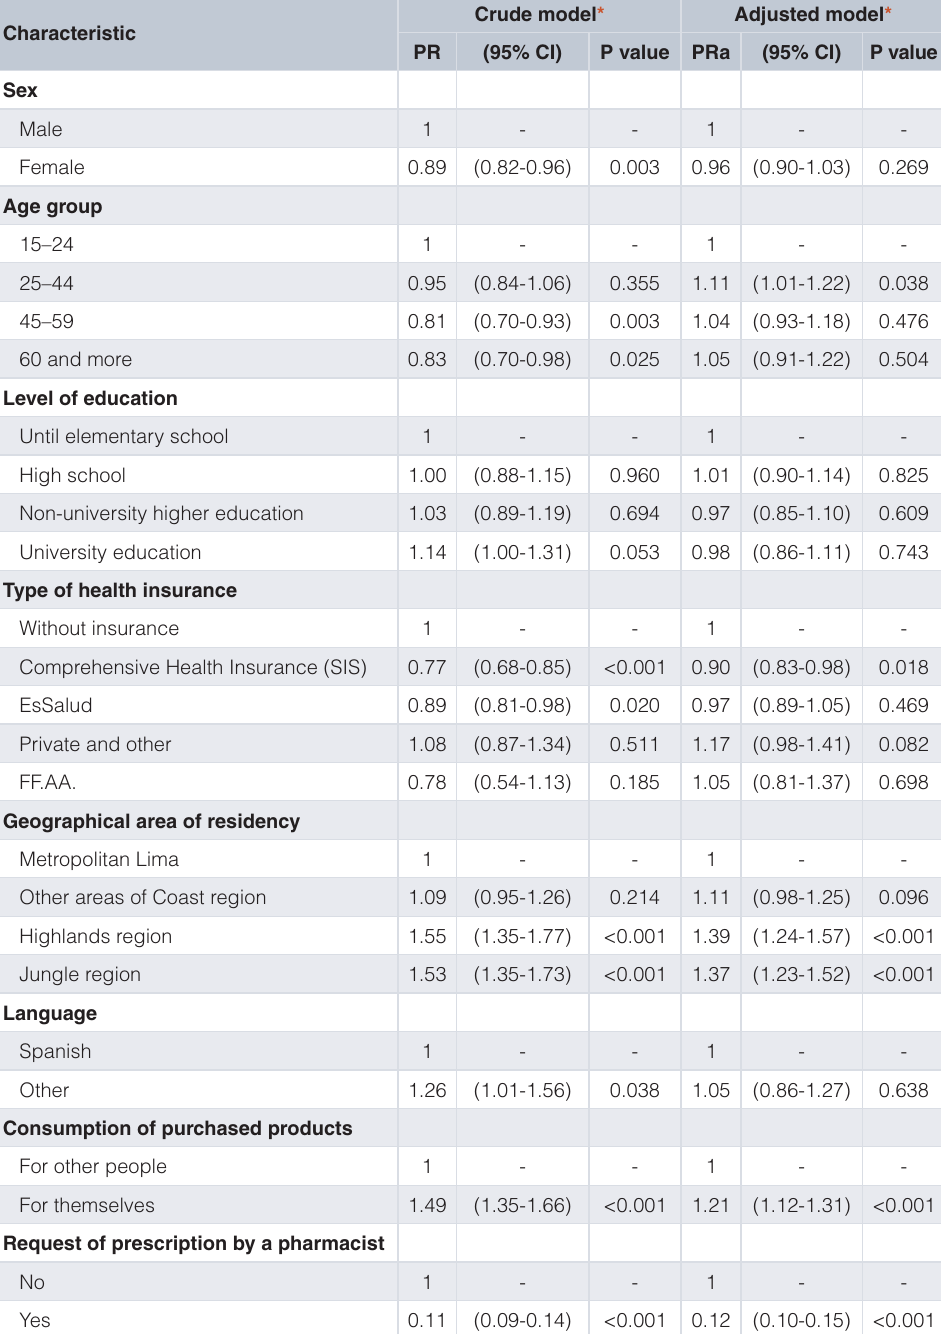
*Regression model of Poisson with a log link function, robust variance and weighting of sampling. ¶ Adjusted by all variables showed in the column and which obtained a value of p<0.2 in crude analysis. PR: prevalence ratio. FF.AA: Health System of Armed Forces and